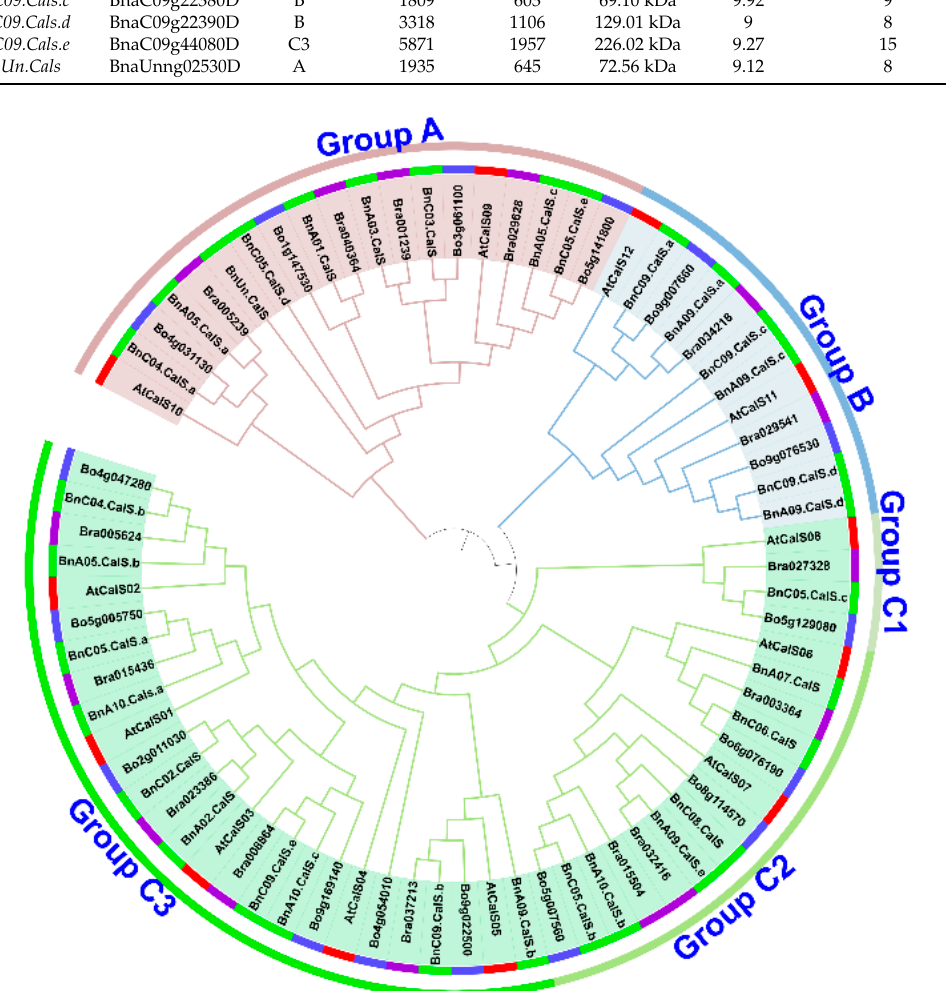
Figure 2. Phylogenetic relationship analysis of CalS genes in A. thaliana , B. napus , B. rapa , and B. oleracea . Protein sequences of twelve AtCalS from A. thaliana , 32 BnCalS from B. napus , 15 BrCalS from B. rapa , and 16 BoCalS from B. oleracea were used to construct a neighbor-joining (NJ) tree. Different colors of the first circle from the tree represent different genes from different species, with red indicating A. thaliana , green indicating B. napus , purple representing B. rapa , and skyblue denoting B. oleracea . The second circle of the tree indicates three groups or five subgroups differentiated by different colors.